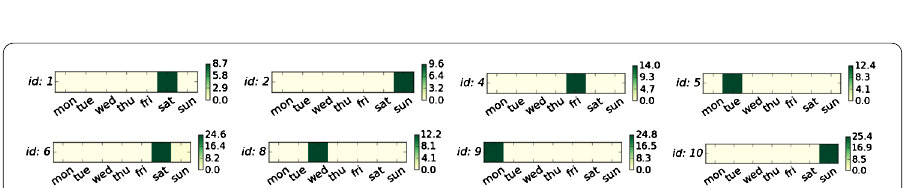
Figure 12 Ta-Feng collective temporal purchasing footprints. Selection of the 12 collective temporal purchasing footprints for Ta-Feng dataset depicted as heat-maps: the darker the color, the higher the number of items purchased. On the x axis are reported the days of the week